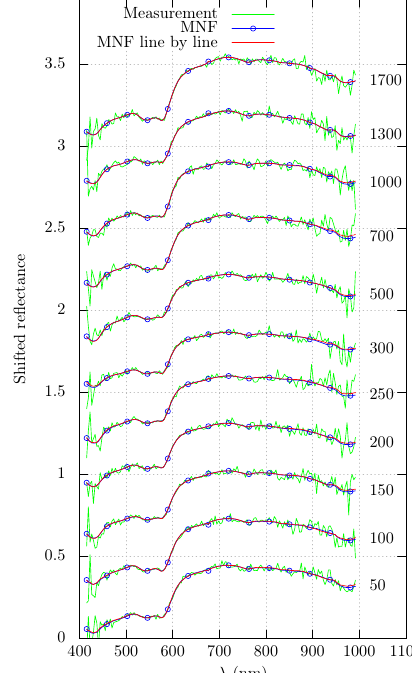
Figure 5. Comparison of denoised spectra along a single image column (experimental data). Corresponding line numbers are shown to the right.